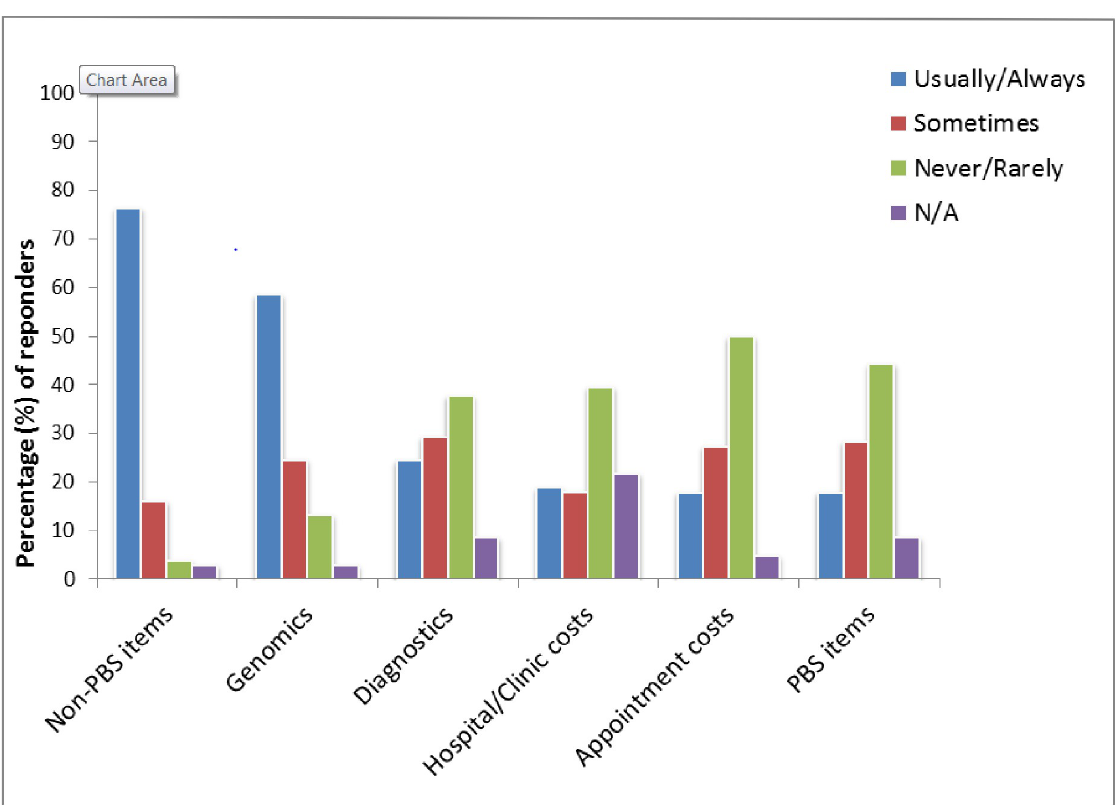
Fig 2. Reported frequency of discussions in the last 12 months about specified out-of-pocket costs. PBS–Pharmaceutical Benefits Scheme (medicines subsidised by the government). Non-PBS–Not on the Pharmaceutical Benefits Scheme (medicines not subsidised by the government).